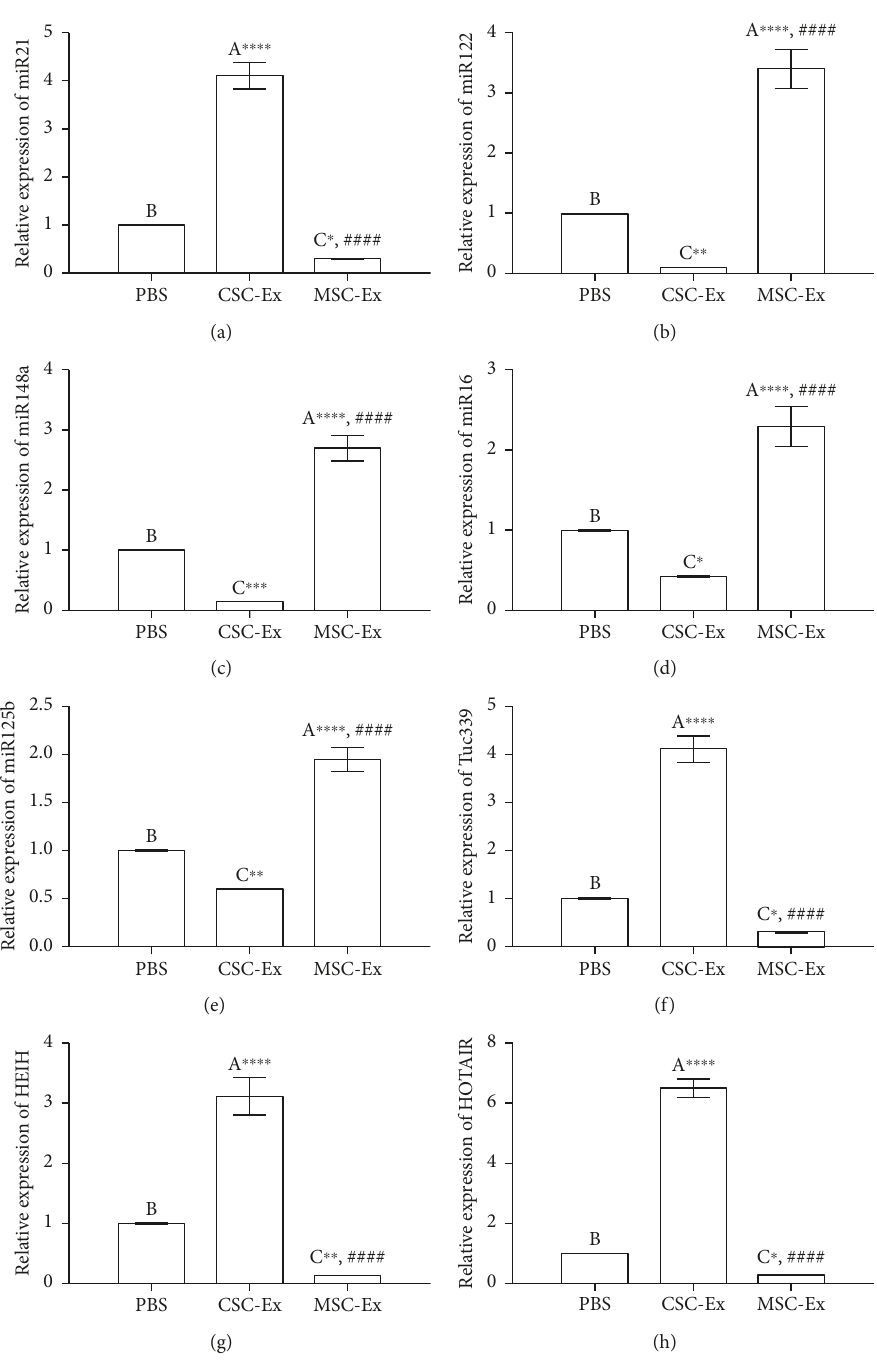
Figure 8: qPCR analysis shows changes in relative gene expression of miR21, miR122, miR148a, miR16, miR125b, lncTuc339, lncHEIH, and lncHOTAIR in livers of DEN-induced HCC rats treated by PBS (PBS) or exosomes derived from CSCs (CSC-Ex) or MSCs (MSC-Ex). Data presented as fold change from the PBS group. Values are expressed as mean ± SEM ( n = 9 ). Di ff erent letters on columns mean signi fi cant di ff erence. ∗ P < 0 05 , ∗∗ P < 0 01 , ∗∗∗ P < 0 001 , and ∗∗∗∗ P < 0 0001 versus PBS group; #### P < 0 0001 versus CSC